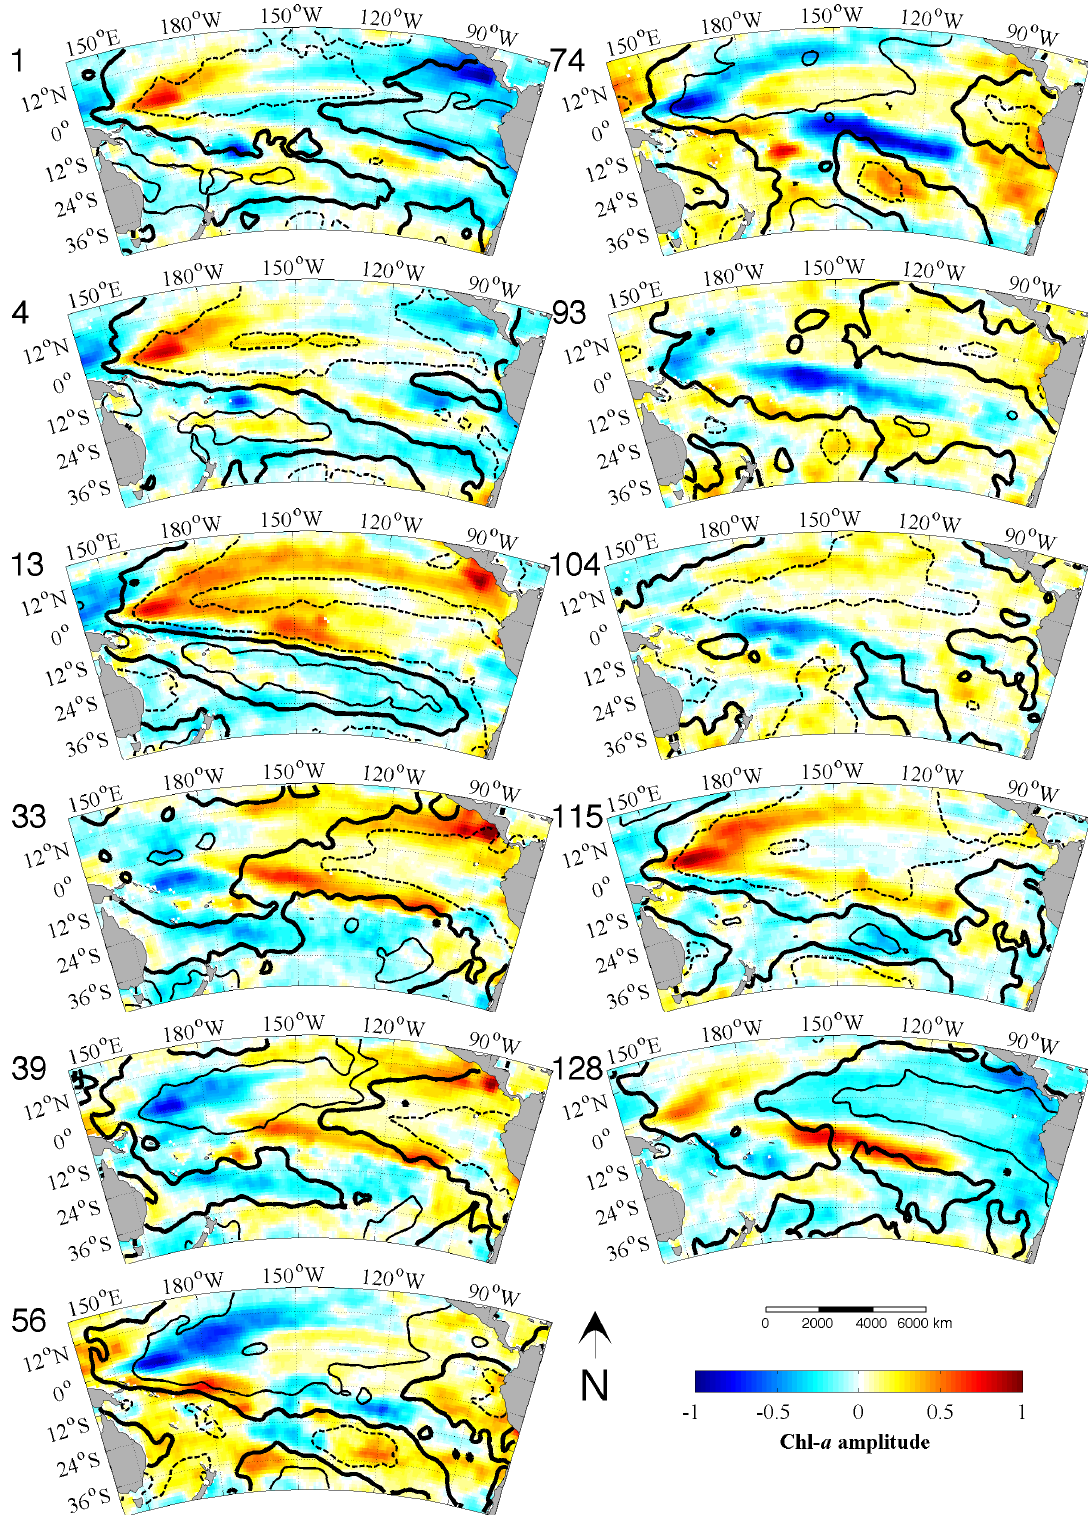
Figure 10. Chl -a A amplitudes from the extended empirical orthogonal function (EEOF)-1 (L = 128) spatial lag-sequence overlaid with projected sea surface temperature anomaly (SSTA) amplitude contours in steps of 3. Units are non-dimensional [18]. Positive values are solid and negative values are dashed, while the zero line is bold. Month number is indicated to the left of each plot. Panels are plotted on a Lambert